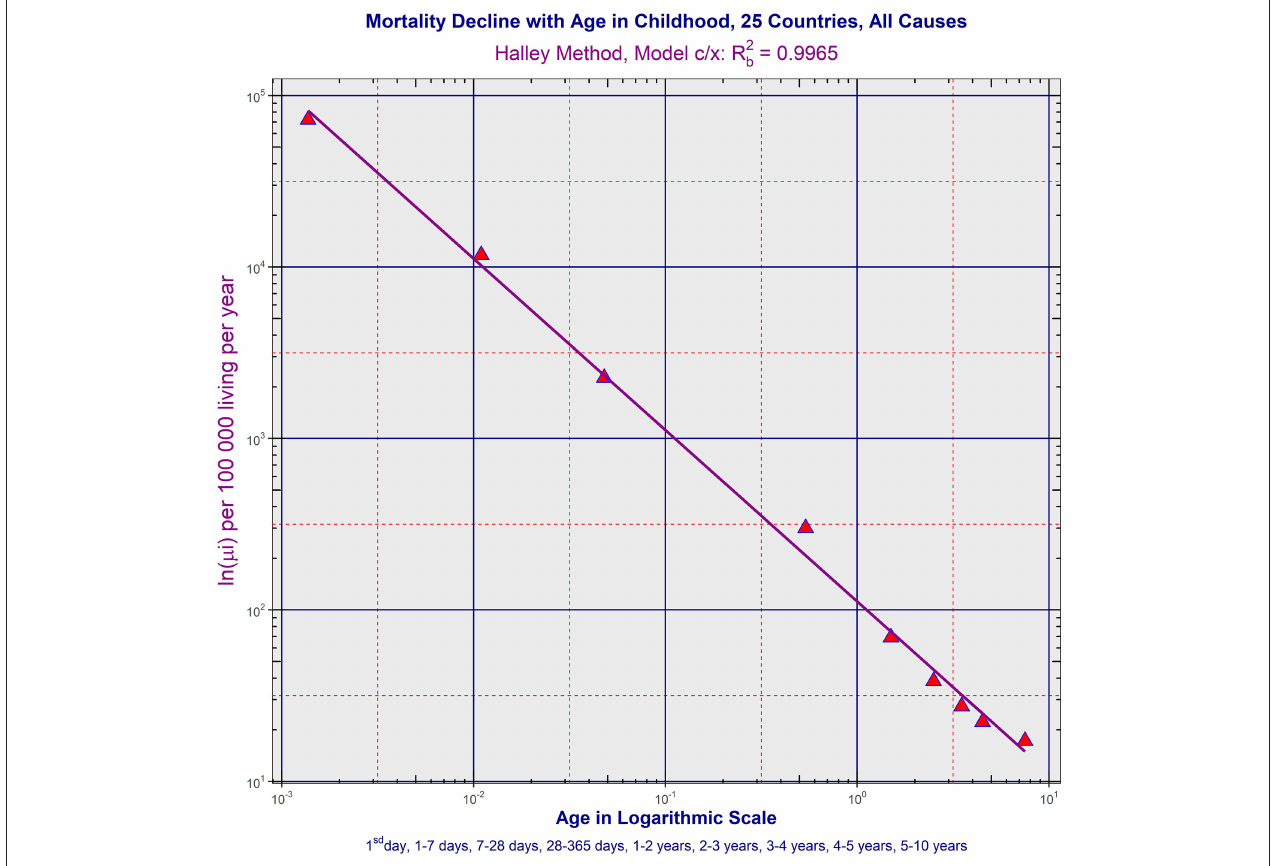
FIGURE 1 | Age trajectory of total mortality in P25.